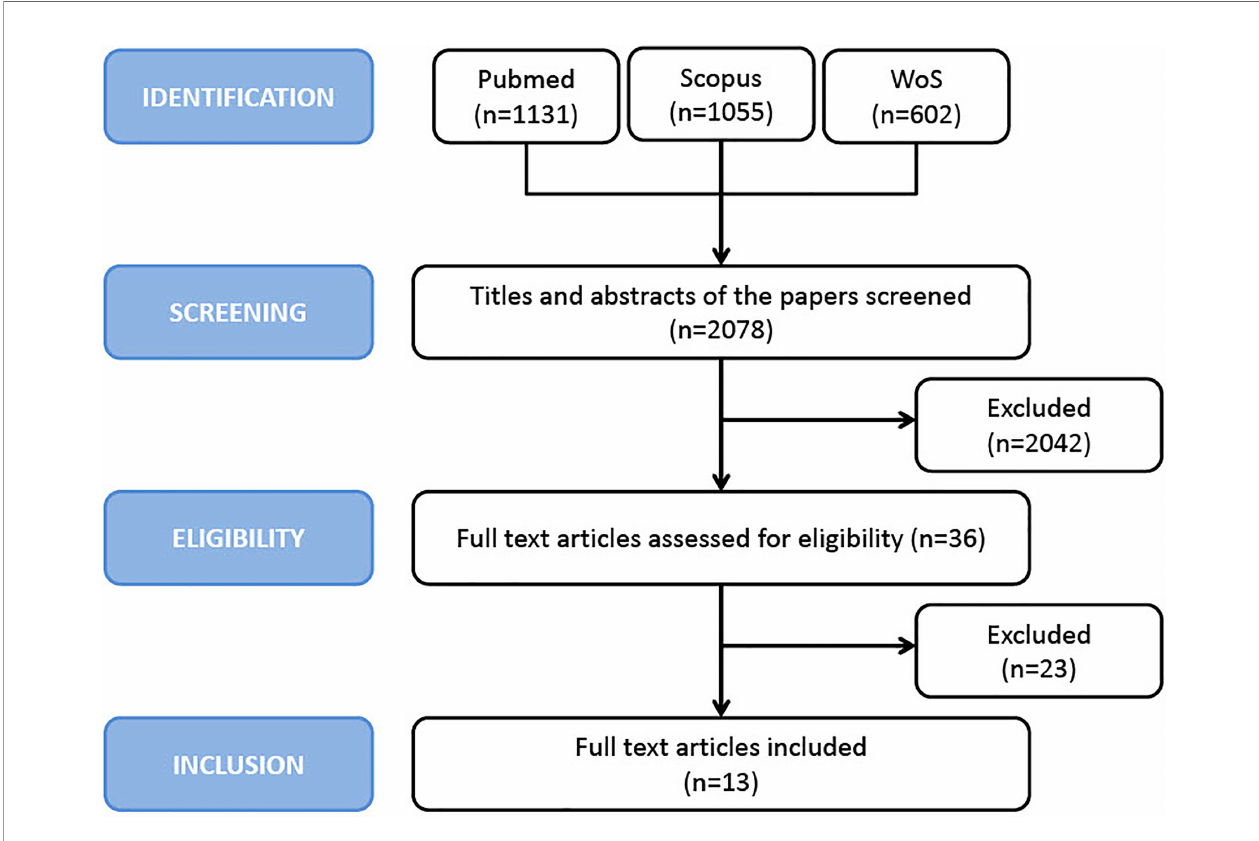
FIGURE 1 | PRISMA fl ow chart of study inclusion